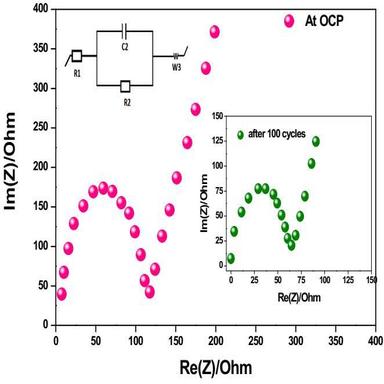
Nyquist plots of IL-β-MNV anode at OCP and Inset: after 100 cycles of GCD.